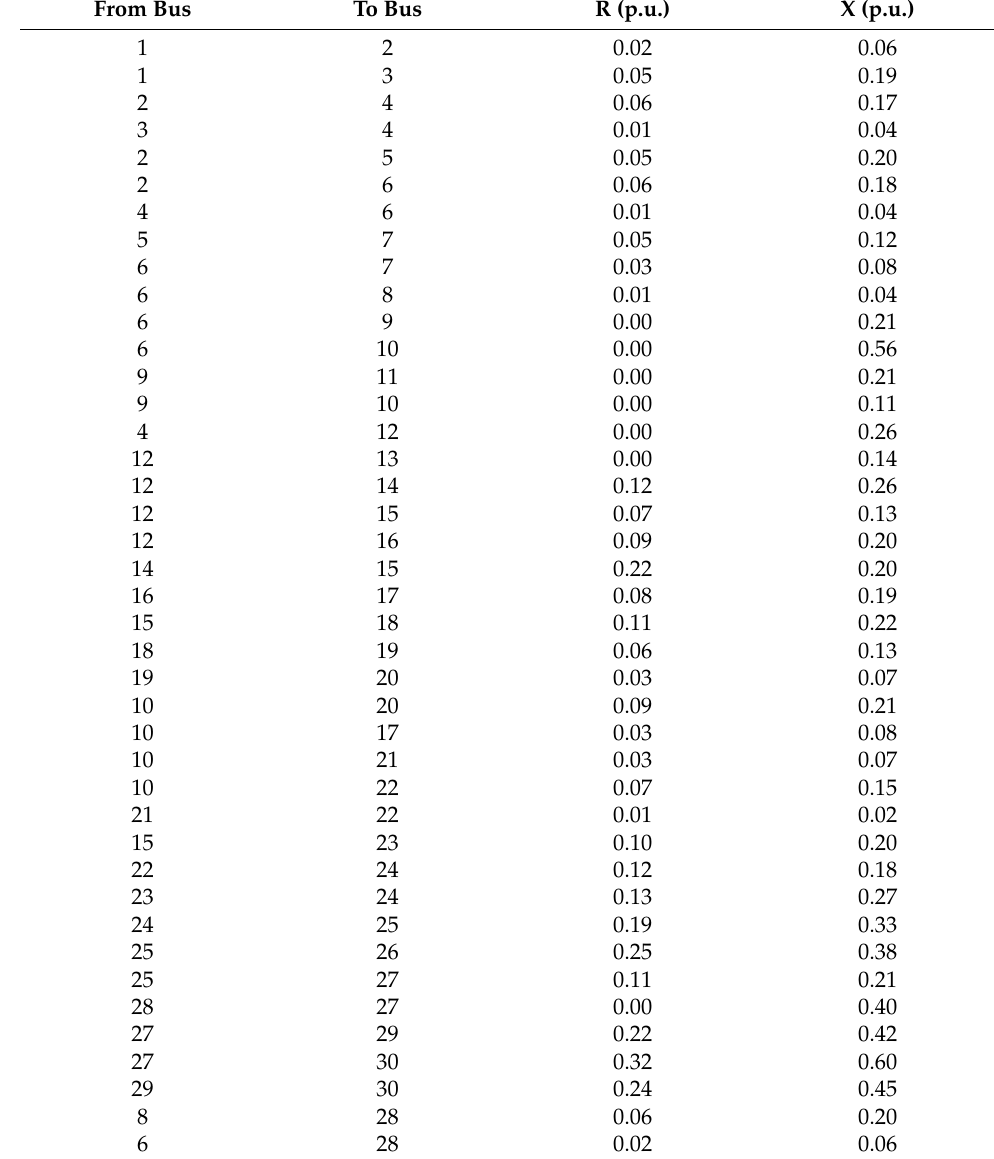
Table A4. Branches